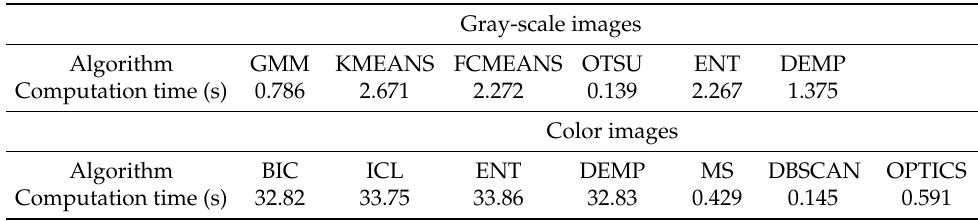
Table 5. Average value of computation time over for each